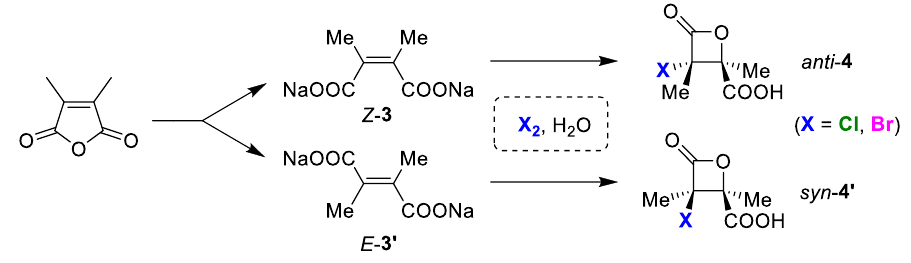
Figure 3. An early example of substrate-switchable cyclization for stereo-selective halo-lactonizations.